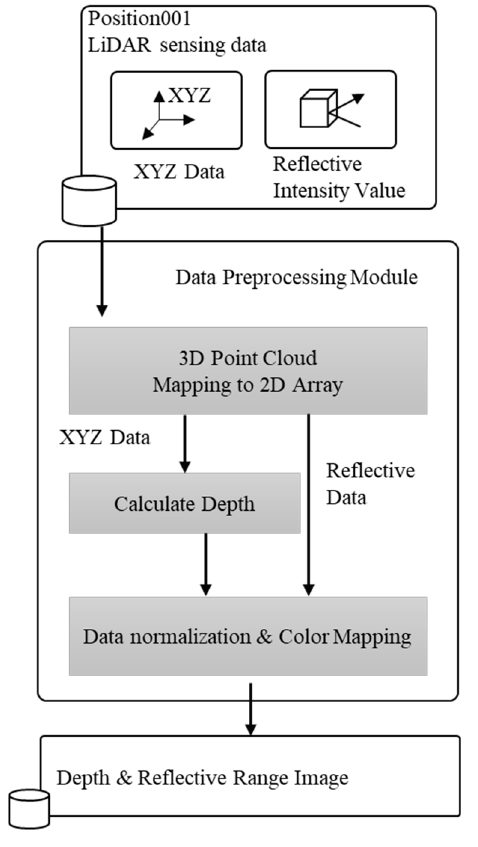
Figure 5. Data preprocessing module overview.